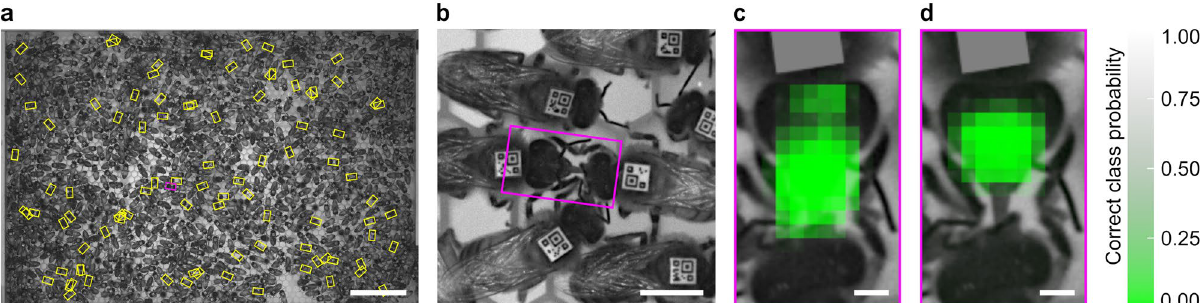
Figure 2. Automatic trophallaxis detection and recipient identification. ( a ) Typical image captured by the honey bee tracking rig, showing barcoded bees inside the observation hive. Rectangles outline image regions identified by our barcode-based region proposal procedure for trophallaxis. Scale bar, 5 cm. ( b ) Zoom-in on the magenta region proposal in ( a ), which shows the head, forelegs and part of the thorax of two bees that engage in trophallaxis. Scale bar, 5 mm. ( c ) CNN input image created from the region proposal in ( b ) superimposed with a map of the output of the CNN for detecting the occurrence of trophallaxis, as a function of the position of a grey square that occludes some pixels (see “Methods”). A false negative from the input image is more likely if pixels corresponding to the mouthparts and proboscis are obscured, indicating that the CNN is able to distinguish salient features of trophallaxis from the background. Scale bar, 1 mm. ( d ) The same input image as in ( c ) but superimposed with a map of the correct class probability for recipient identification. This map suggests that the CNN for identifying the recipient relies on visual cues obtained from the mouthparts of the recipient, which, unlike those of the donor, are always visible and closely aligned with the proboscis. Scale bar, 1 mm.